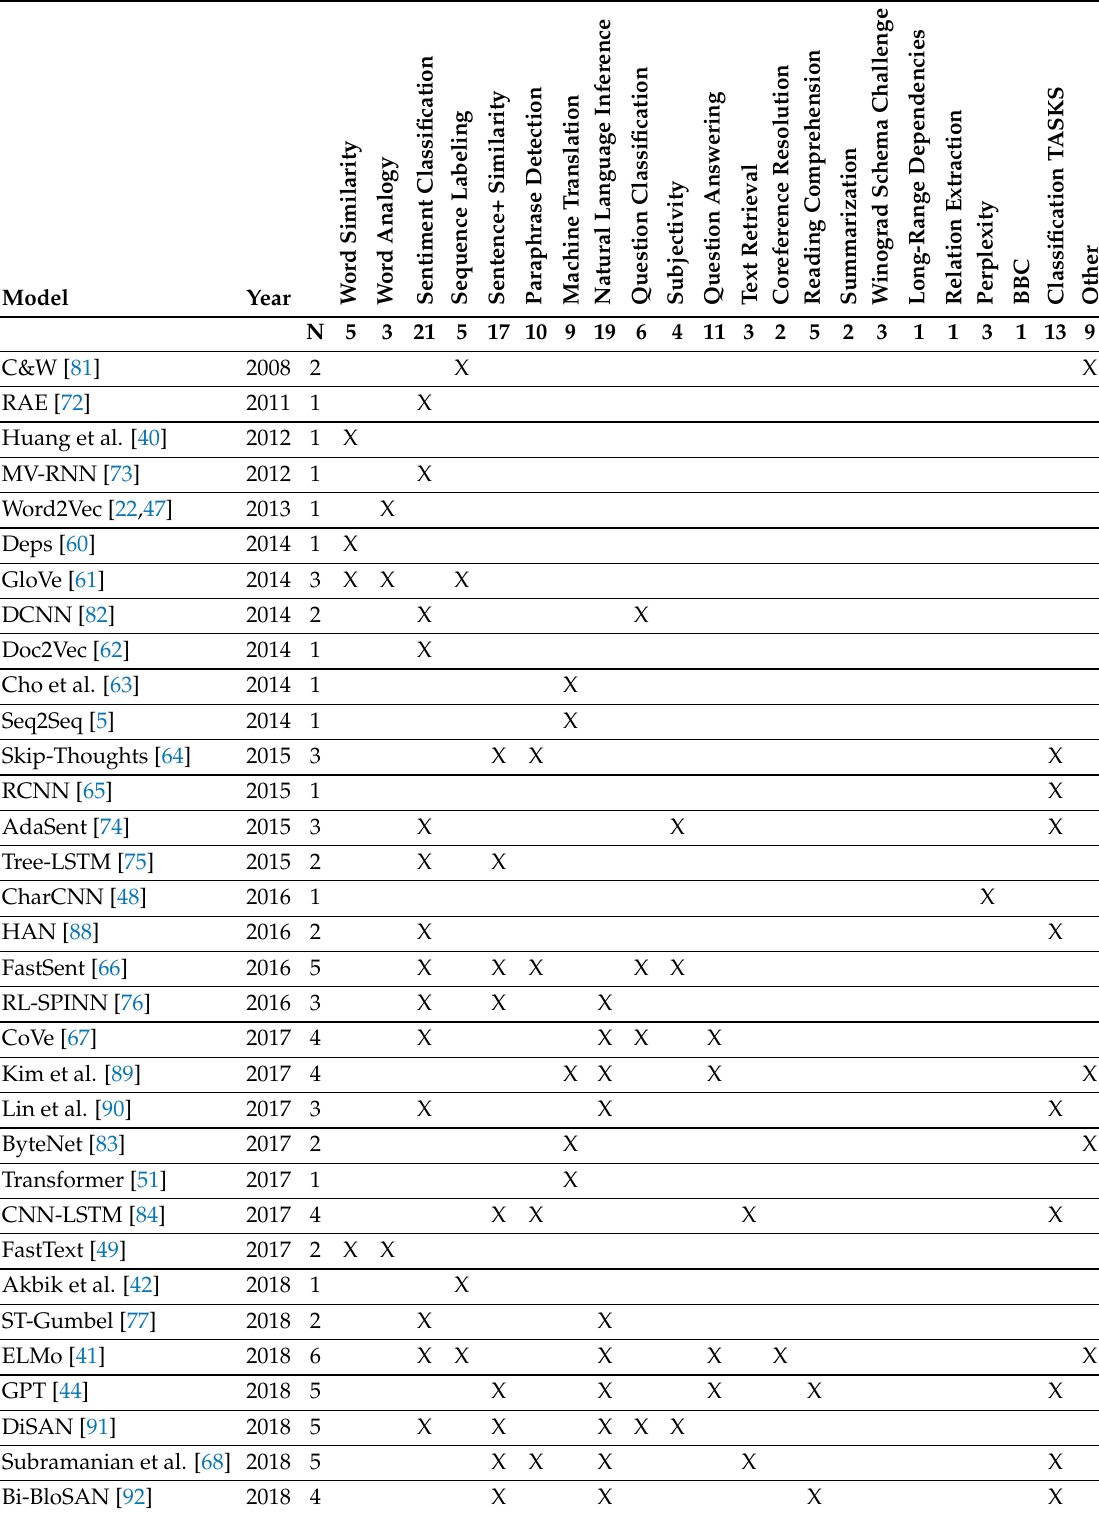
Table A2. Relevant tasks each of the models used for evaluation. In rows, N is the total number of tasks per model. In columns, N is the total number of models per